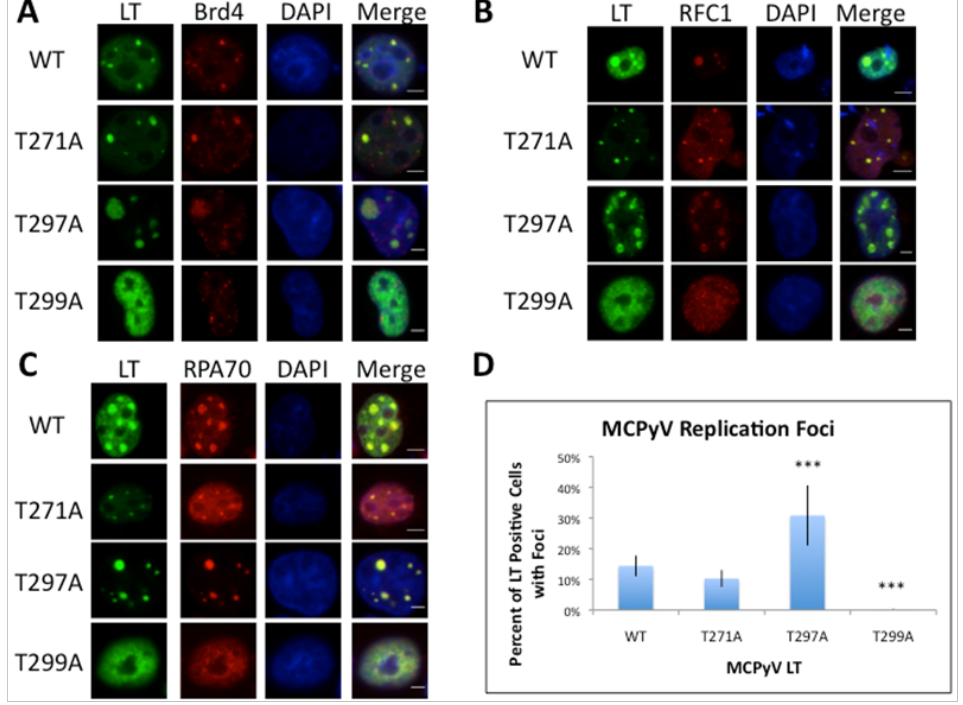
Figure 3. MCPyV LT phospho-mutant proteins form viral replicaiton foci at altered efficiencies. ( A – C ) C33A cells were co-transfected with an MCPyV Ori plasmid and the indicated MCPyV LT phospho-mutant. Forty-eight hours post transfection, cells were fixed and stained for LT (green) and the indicated cellular factor (Red). Nuclei were counterstained with DAPI. Bar = 3 µm; ( D ) Nuclei stained positively for LT as shown in ( A – C ) were scored for the presence of viral replication foci (at least 150 LT positive nuclei were counted in triplicate per transfection). Bar indicates standard deviation from the mean from at least three independent experiments. Statistical significance was calculated against WT LT using a one-way ANOVA (*** p <